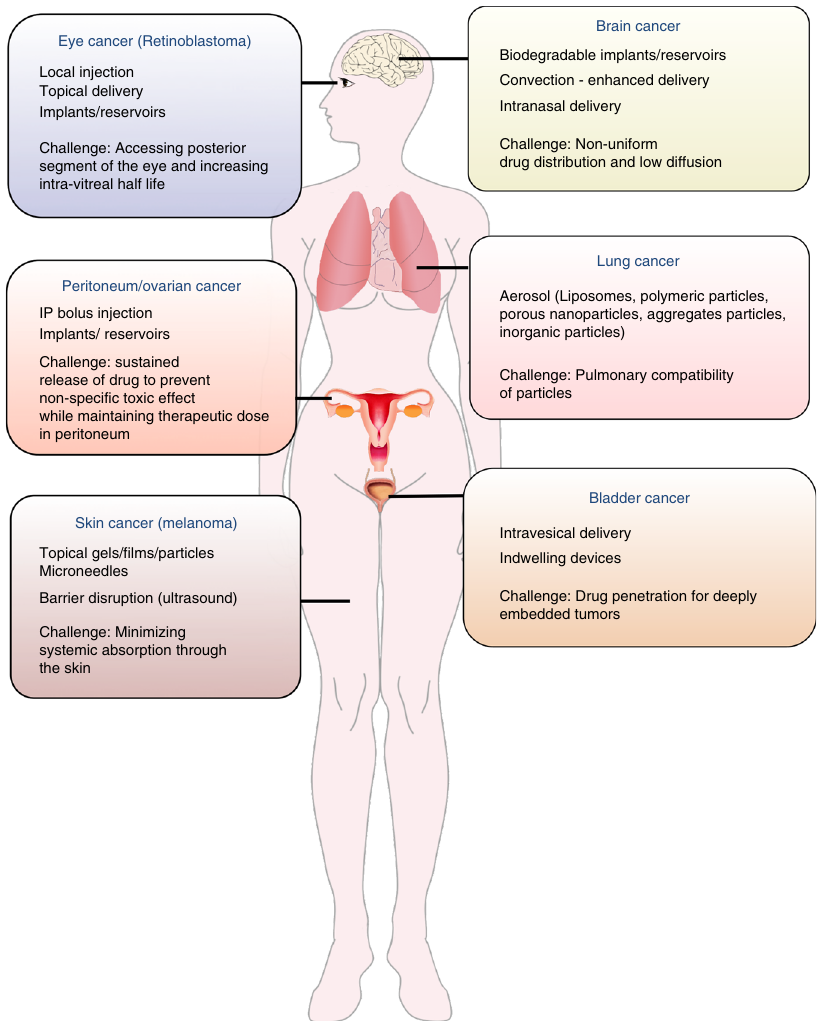
Fig. 5 Biological and technical barriers to the success of local drug delivery. Local administration is a promising strategy for targeted drug delivery in certain cancers. However, there are still some cancer-speci fi c biological and technical barriers that need to be overcome by the clinical success of this